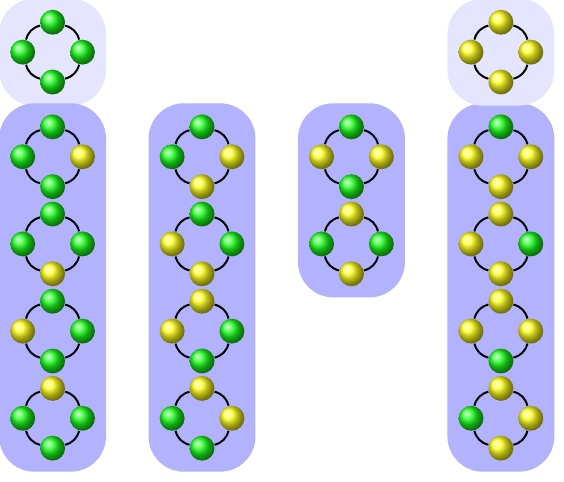
Fig. 7. Orbits of necklaces with 4 beads in 2 colours under cycle action by Z + 2 The monocoloured necklaces (top left and top right) each has orbit of size 1 . The multicoloured necklaces have orbits in an irregular pattern, with sets of size 4 or 2 . By Orbit-Stabilizer theorem, the possible orbit sizes of necklaces are divisors of 4 , i.e. 1 , 2 or 4